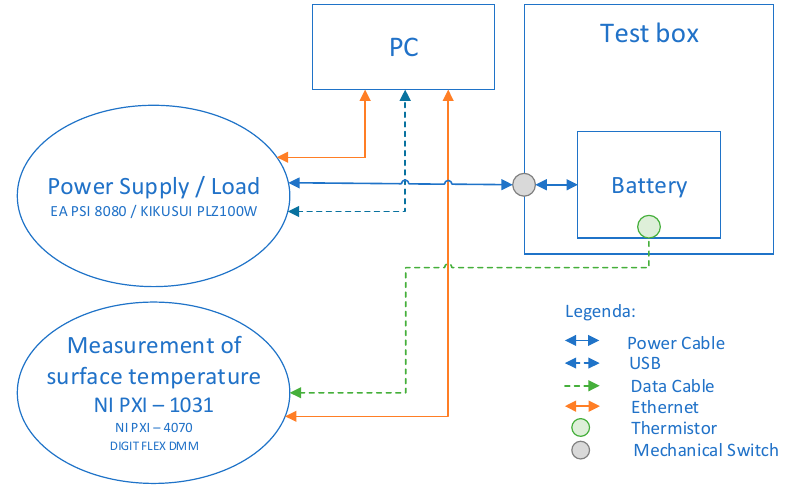
Figure 8. Block diagram of test-stand for traction batteries recovery.